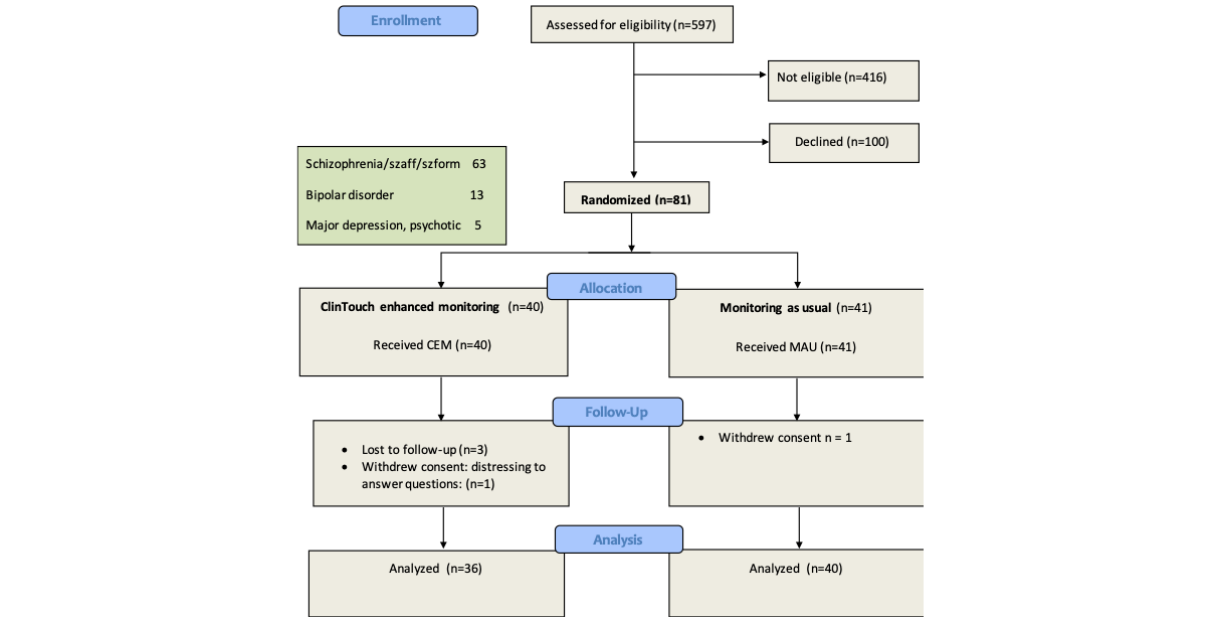
Figure 1. Randomized controlled trial flow